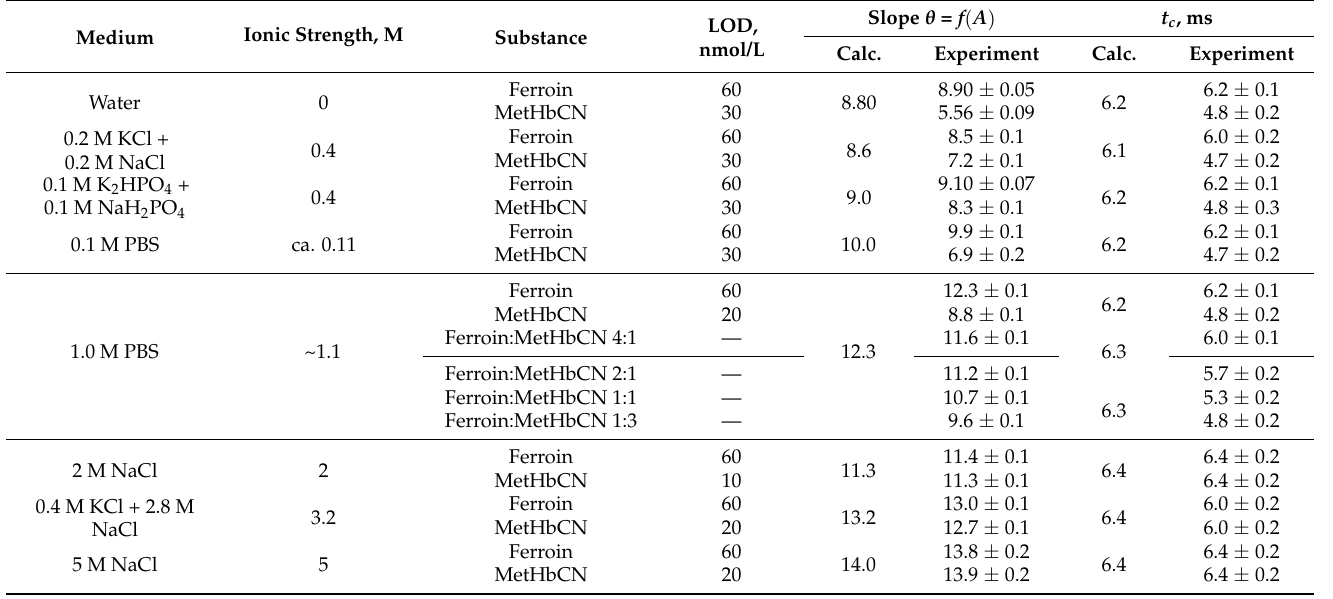
calculated by Equation (5), and theoretical slopes were calculated by Equation (14).